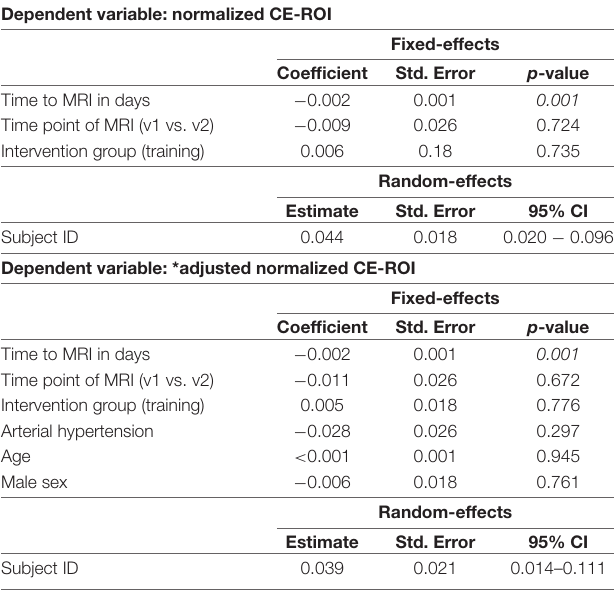
TABLE 4 | Linear mixed models for normalized contrast enhancement within region of interest (normalized CE-ROI) at MRI before (v1) and after (v2) intervention.